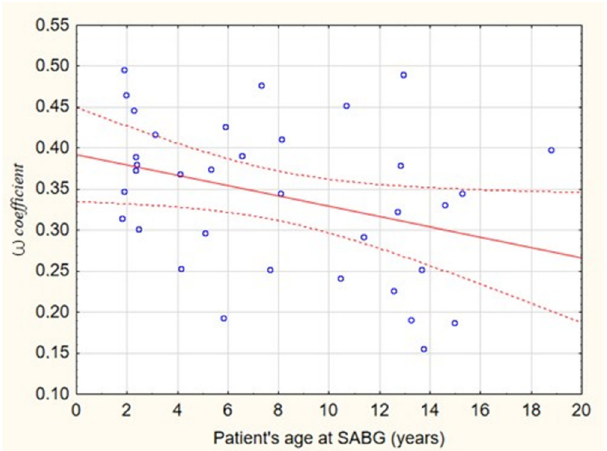
Figure 3. Scatter plot depicting the correlation between Ꞷ coefficient and patient’s age at SABG ( r = − 0.34, p = 0.045). Regression equation is given by: Ꞷ = 0.392 − 0.006 × SABG.